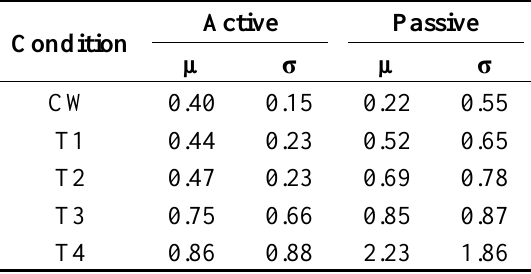
Table 6. Amphora: accuracy evaluation (mean distance µ in mm and standard deviation σ).